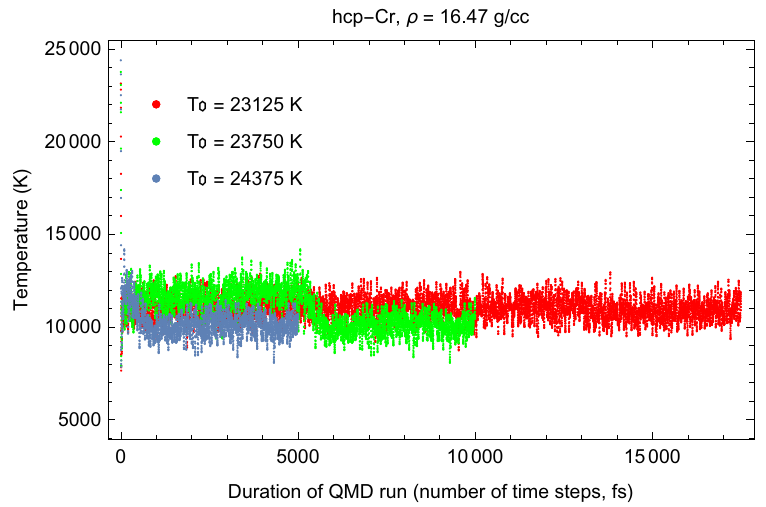
Figure 4. Time evolution of temperature in three QMD runs with initial temperatures (T 0 s) separated by 625 K. The middle run is the melting run during which T decreases from ∼ 12,000 K for the superheated state to 10,190 K for the liquid at the corresponding melting